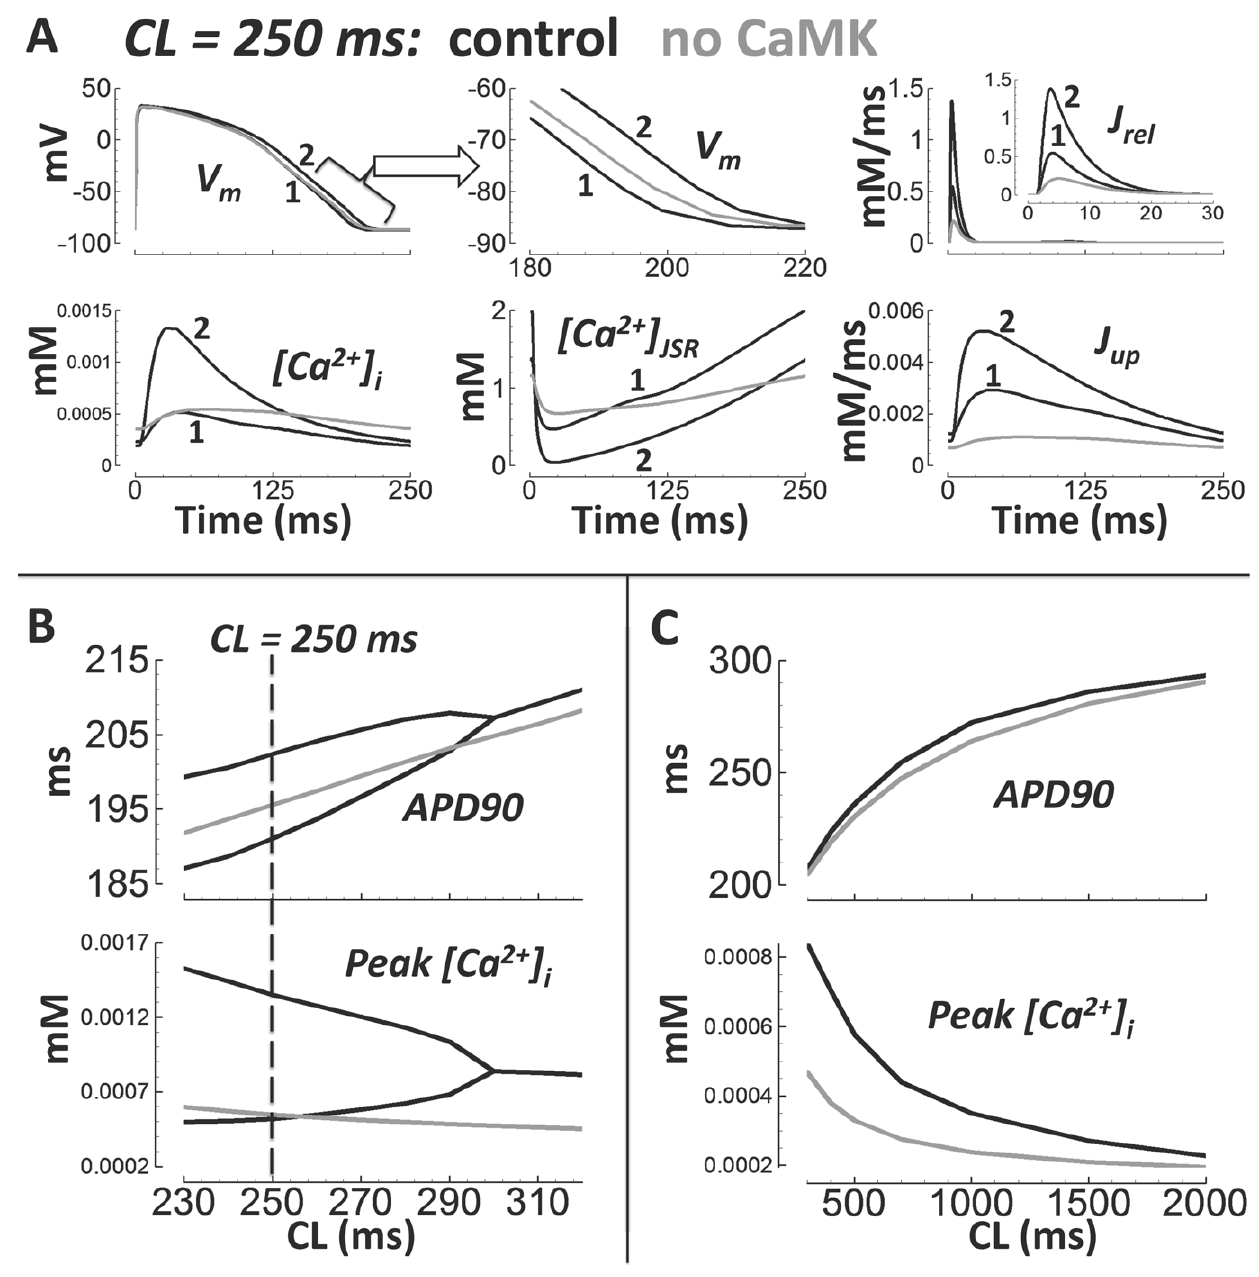
Figure 14. AP and Ca 2 + alternans at fast pacing. Black lines are control. Gray lines are without CaMK. The two consecutive beats are labeled 1 and 2. A) Pacing at CL=250 ms. From left to right, top to bottom: AP, expanded time scale showing AP repolarization, J rel (inset is expanded time scale), [Ca 2 + ] i , [Ca 2 + ] JSR , and J up . B) Rate dependence of APD (top) and peak [Ca 2 + ] i (bottom) at fast rates (alternans bifurcations disappear without CaMK). C) Same as panel B, but at slower rates (no